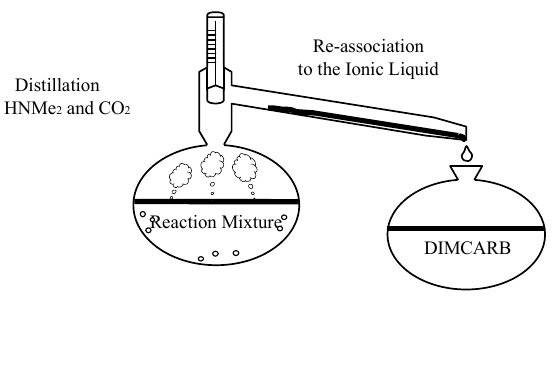
Figure 3 . Distillation of